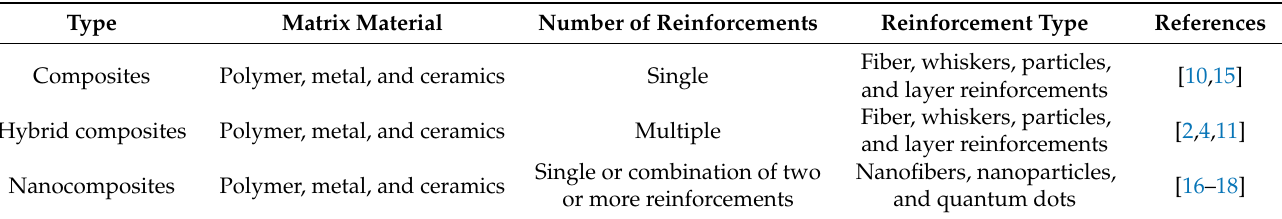
Table 1. Classification of matrix materials and